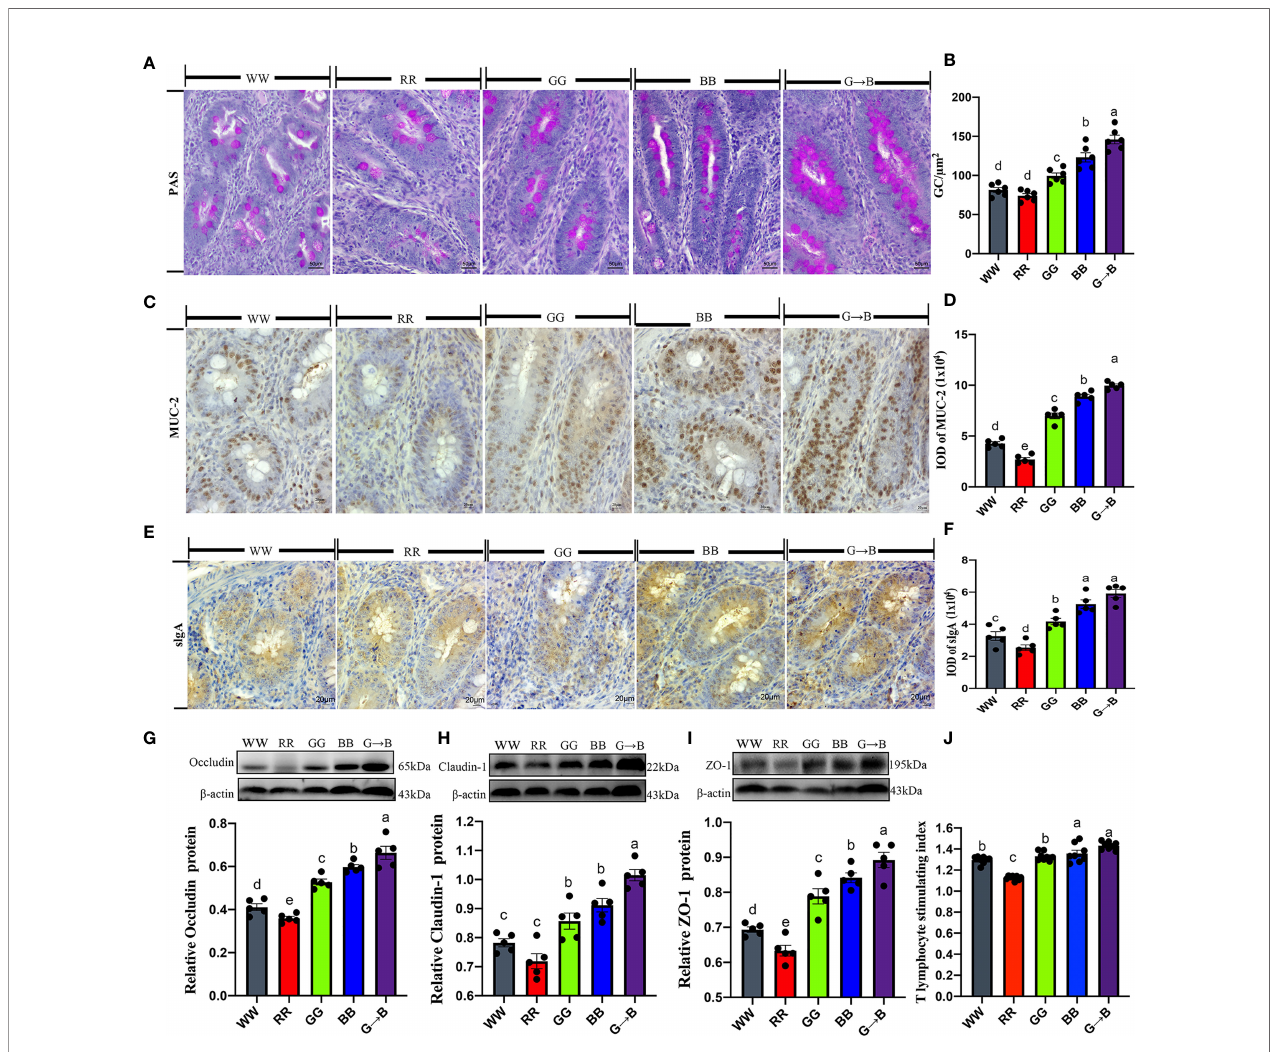
FIGURE 8 | Effects of different monochromatic light combinations on periodic acid-Schiff staining of cecum tissue sections (A) , the number of goblet cells per square micrometer in the cecum (scale: 50 m m) (B) , immunohistochemical staining of MUC-2 in cecum sections (scale: 20 m m) (C) , the integrated optical density (IOD) of MUC-2 ‐ positive cells (D) , immunohistochemical staining of sIgA + cells in cecum sections (scale: 20 m m) (E) , the IOD of sIgA + cells (F) , occludin, claudin ‐ 1, and ZO ‐ 1 protein expression (G – I) , and cecal tonsil T proliferation stimulation index (J) in chicks at P42. WW, white light; RR, red light; GG, green light; BB, blue light; G ! B, green light and blue light combination. The results are presented as means ± SEM. Different letters indicate signi fi cant differences between the treatments at the same age ( P <